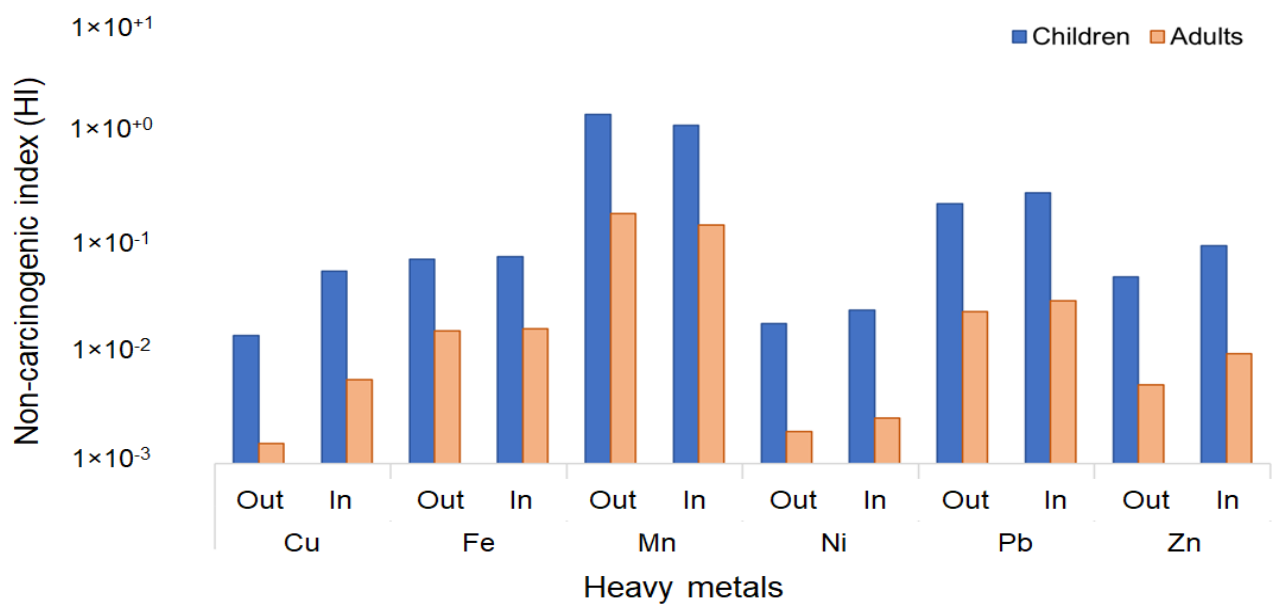
Figure 7. Mean values of the non-carcinogenic index (HI) for children and adults indoors (In) and outdoors (Out).